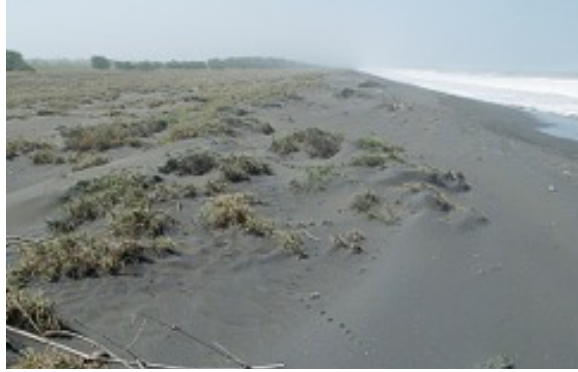
Fig. 2. Study area in Yogyakarta, Indonesia.